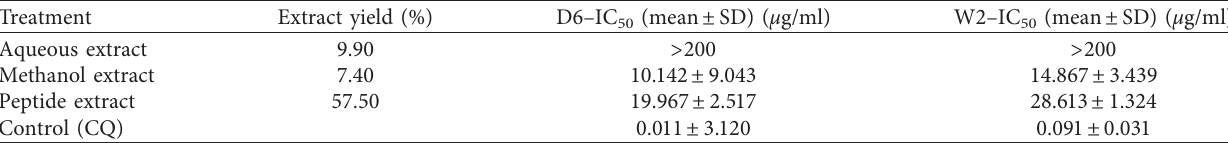
Table 3: In vitro antiplasmodial activity of three extracts of soybeans Glycine max.